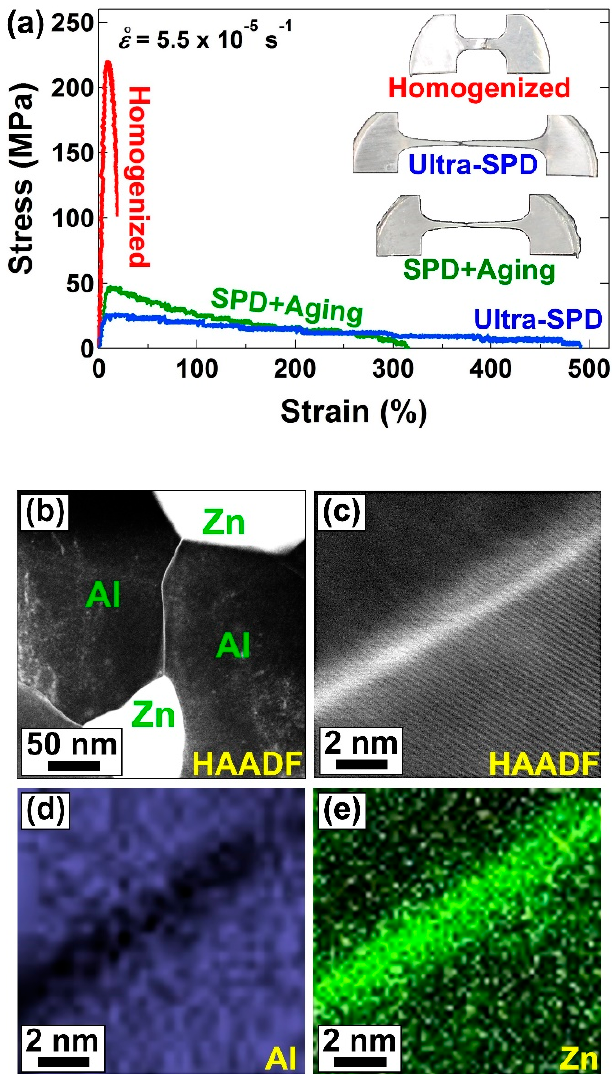
Figure 3. Room-temperature superplasticity in Al-Zn alloy after ultra-SPD. ( a ) Tensile stress-strain curves, including appearance of tensile specimens after pulling to failure, after homogenization, ultra-SPD and ultra-SPD followed by 100-day aging at room temperature. ( b ) High-angle annular dark-field (HAADF) image showing the distribution of Al and Zn atoms after ultra-SPD processing in which bright and dark contrasts correspond to Al and Zn, respectively. ( c ) HAADF lattice image of Al-Al grain boundary and corresponding elemental mapping with ( d ) Al and ( e ) Zn after processing by ultra-SPD via HPT [46].